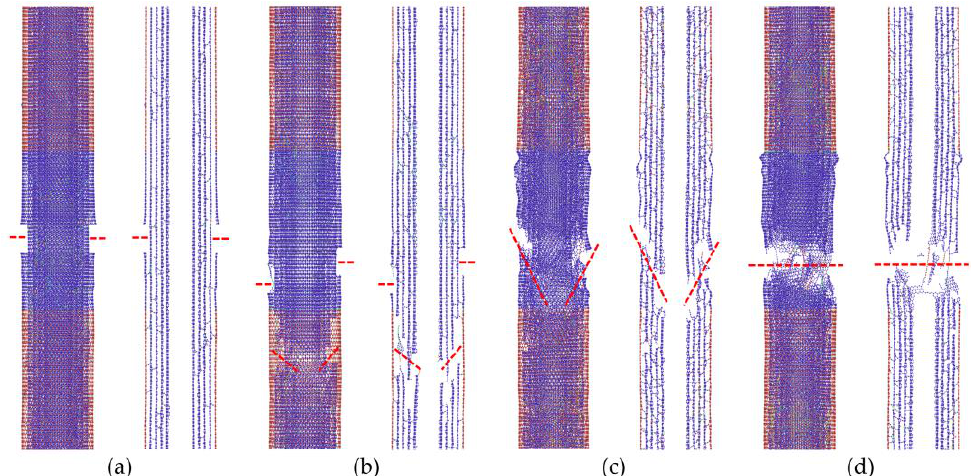
Figure 4. Fracture patterns of the zigzag-type 5WCNTs assigned with different crosslink densities. ( a ) “Sword-in-sheath” fracture on the 0.5% crosslink model (in every wall) with nominal strength of 47 GPa; ( b ) “Sword-and-sheath” fracture on the 0.75% crosslink model with nominal strength of 50 GPa; ( c , d ) “Near-clean-break” and “clean-break” fracture on the 1.5% crosslink model with nominal strength of 53 GPa and 52 GPa, respectively.